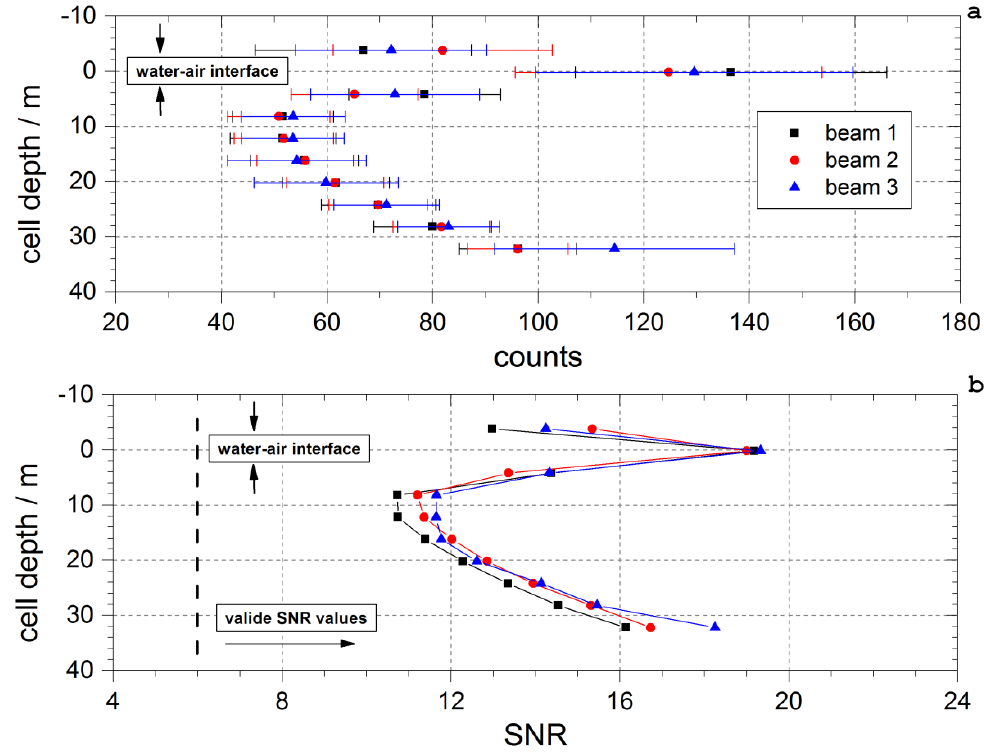
Figure 5. ADCP acoustic signals: ( a ) average counts of the three beams vs. cell depths; ( b ) SNR values.